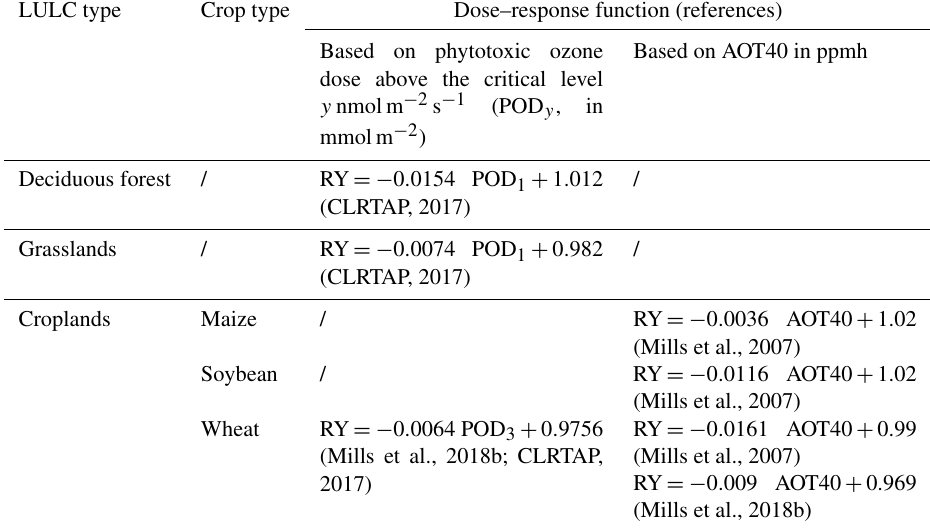
Table 3. Dose–response functions used to estimate the LULC- and crop-specific relative yield losses (i.e., 1 – relative yield, RY) due to O 3 exposure and uptake, along with their